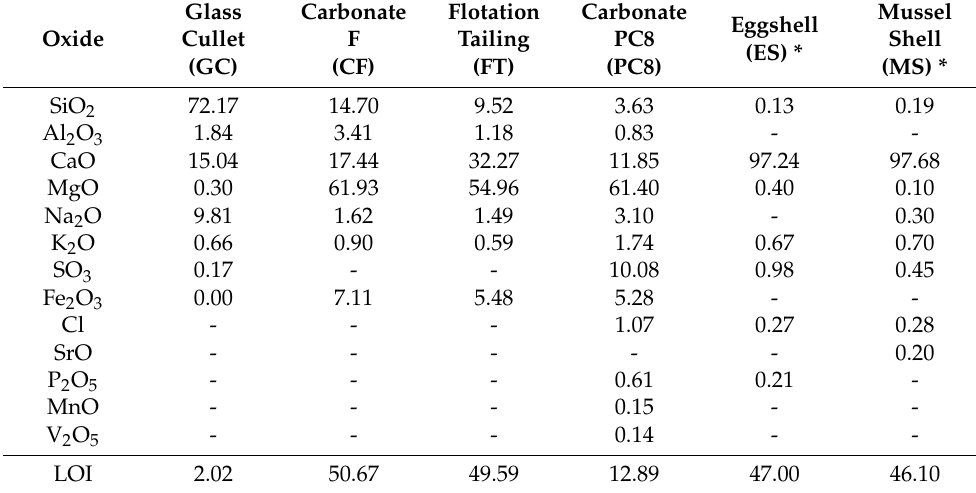
Table 2. Main chemical composition (expressed as wt. %) of the raw materials, determined by XRF. Carbonate Glass F Oxide Cullet (GC)